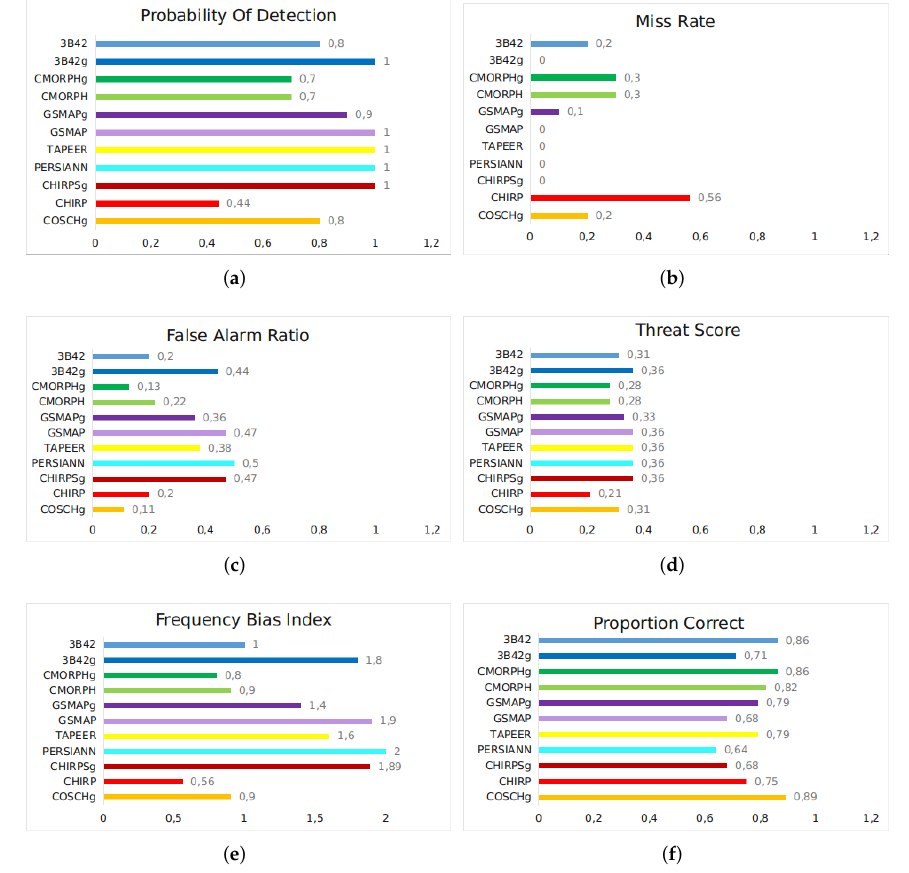
Figure 6. Bar graphs of ( a ) Probability Of Detection (POD); ( b ) Miss Rate (MR); ( c ) False Alarm Ratio (FAR); ( d ) Threat Score (TS); ( e ) Frequency Bias Index (FBI) and ( f ) Proportion Correct (PC) for five days of accumulated precipitation over the south region of Brazil from 24 June 2014 to 28 June